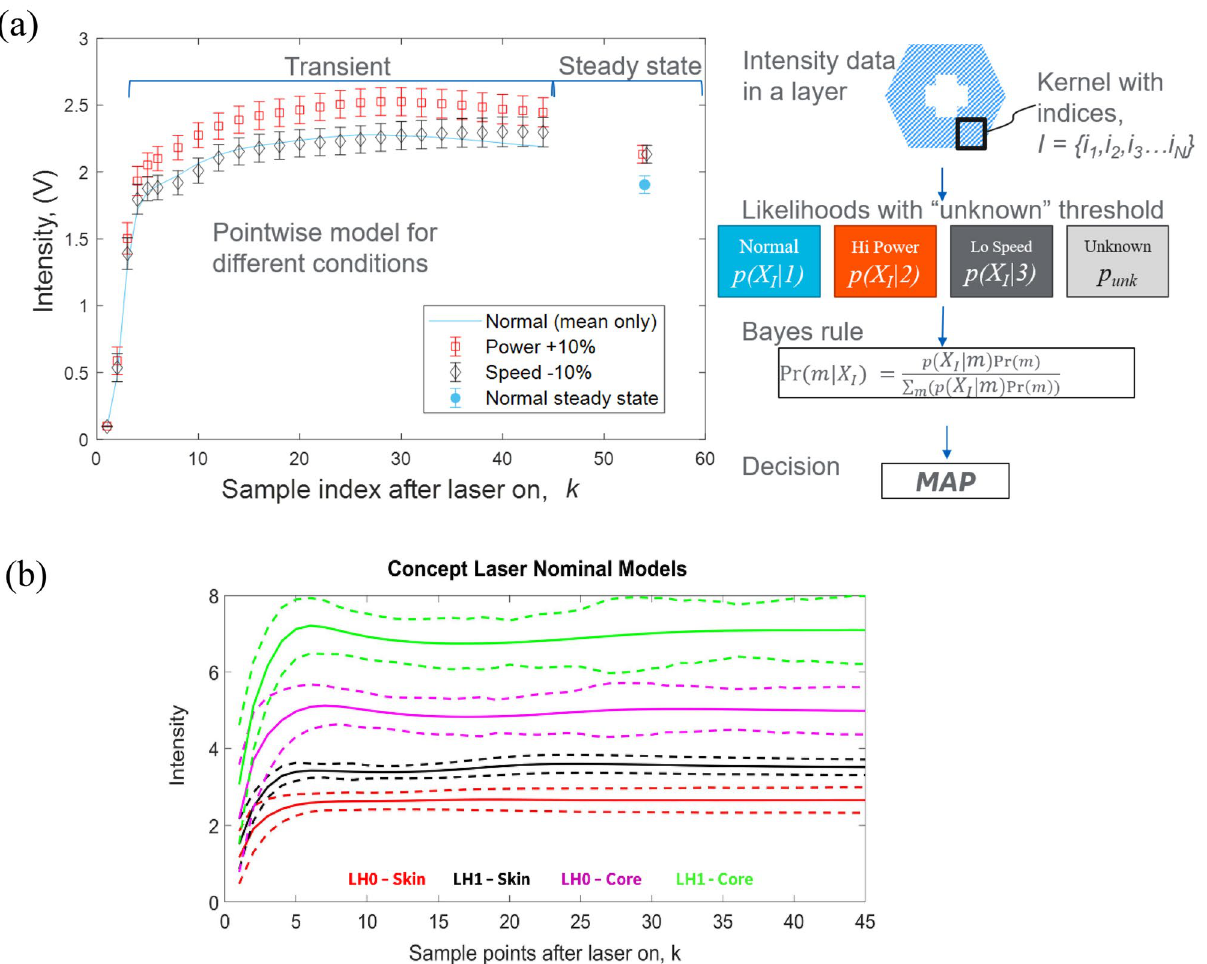
Figure 2. ( a ) Multiple model hypothesis test using a point-wise model of the melt pool response during laser strikes. Left side of figure shows actual models for the on-axis photodiode for the normal process and representative faulted processes. The right side illustrates a square spatial kernel that aggregates points across multiple laser strikes. These points are then analyzed as described in the text. ( b ) Four nominal models to analyze Concept Laser data. The solid lines represent the mean intensity models while the dashed lines represent one standard deviation